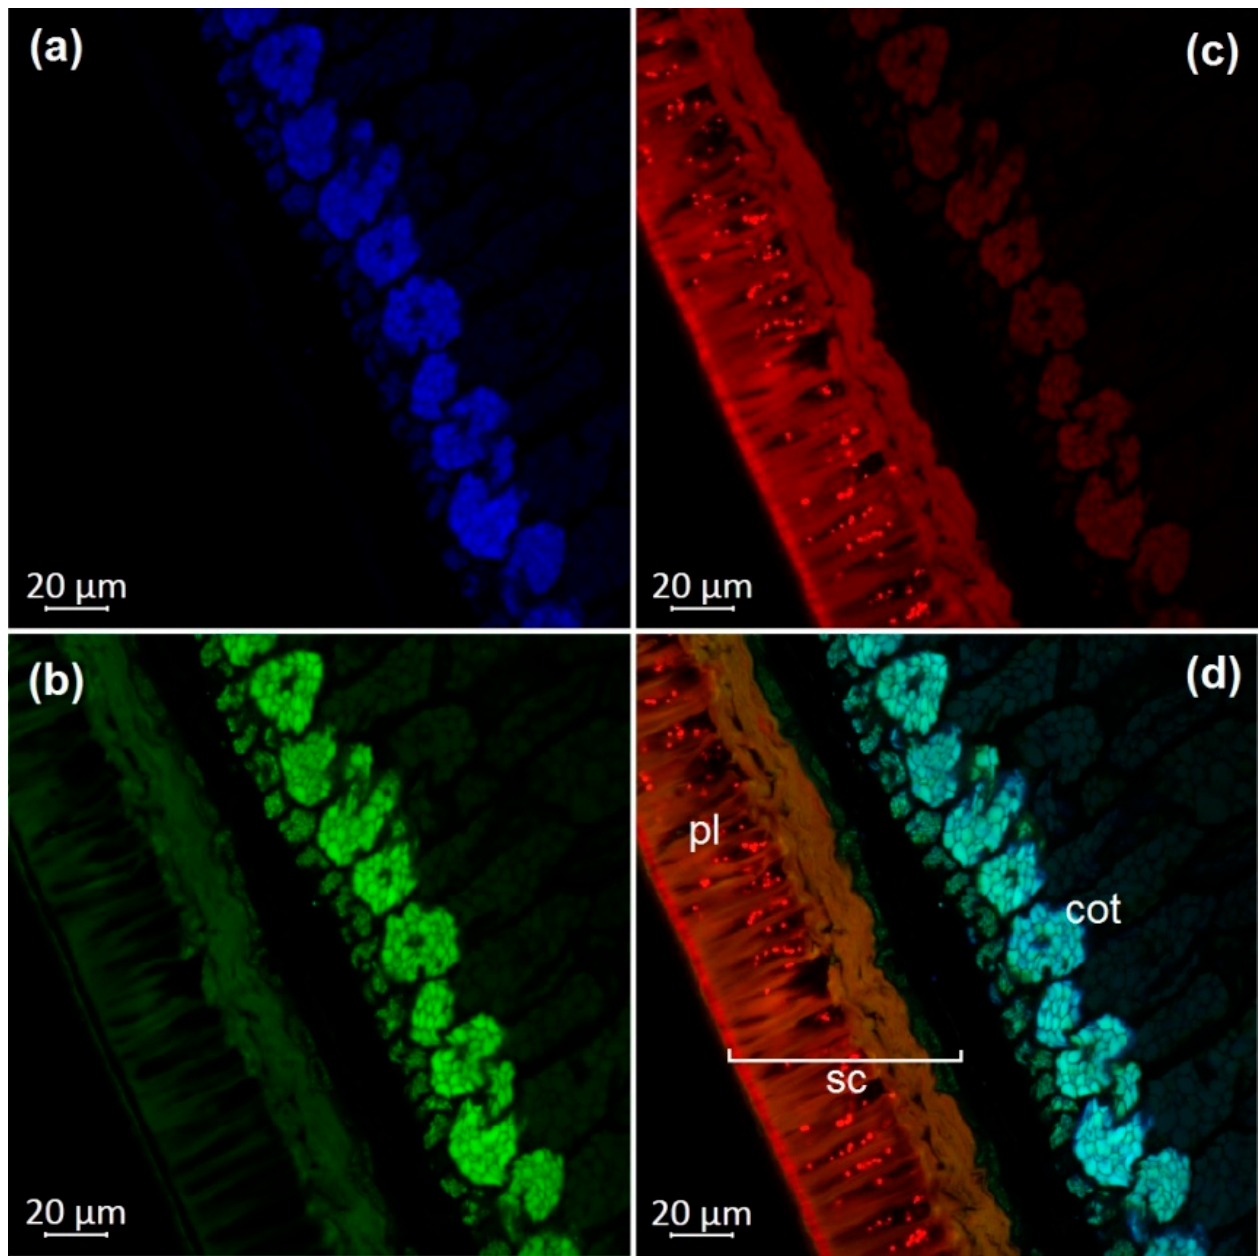
Figure 4. A transverse section of a soybean seed (variety k-569): ( a ) excitation at 405 nm with emission in the range of 400–475 nm (blue); ( b ) excitation at 488 nm with emission in the range of 500–545 nm (green); ( c ) excitation at 488 nm with emission in the range of 620–700 nm (red); ( d ) merged; cot, cotyledon; pl, palisade layer; sc, seed coat.